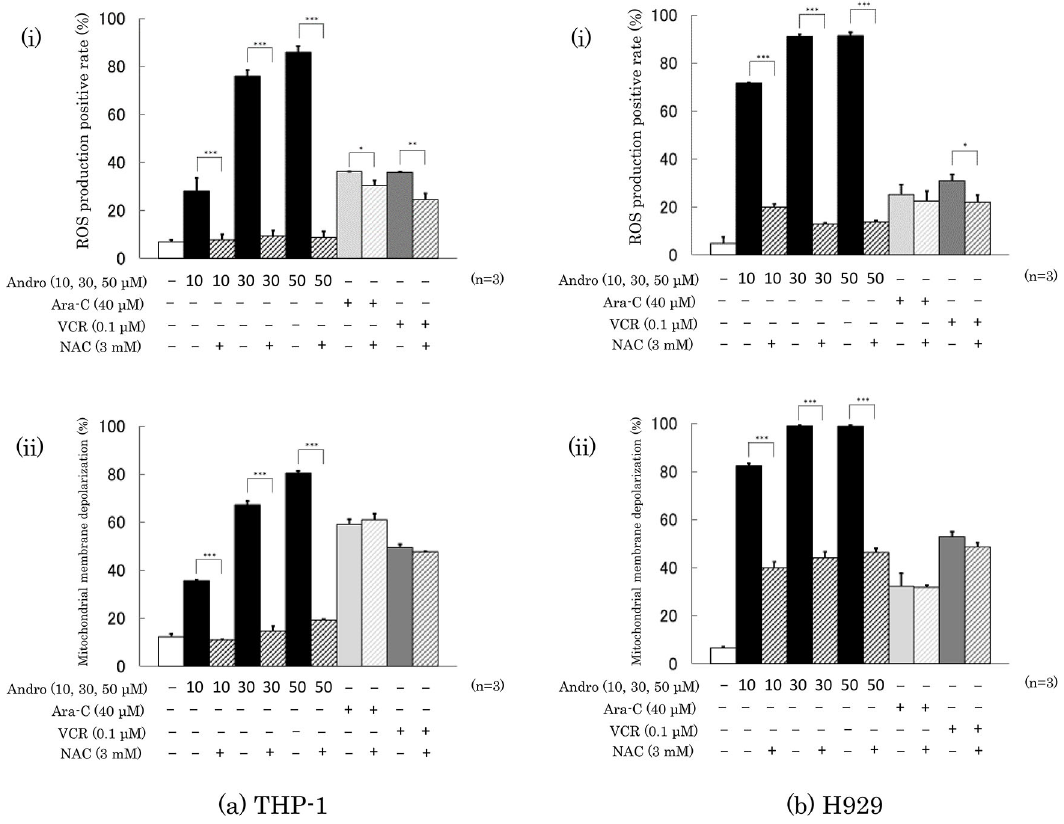
Figure 6. Effects of treatment for 24 h with Andro, Ara-C, or VCR onROS production (a-i, b-i) and mitochondrial membrane depolarization (a-ii, b-ii) in THP-1 (a) and H929 (b) cells. The presence of the ROS production inhibitor NAClargelyreduced theenhancingeffects ofAndroonbothparametersineithercelltype,whereasNAChadlittleor no impact on the effects of Ara-C and VCR. The results are expressed as mean (cid:4) SD of three